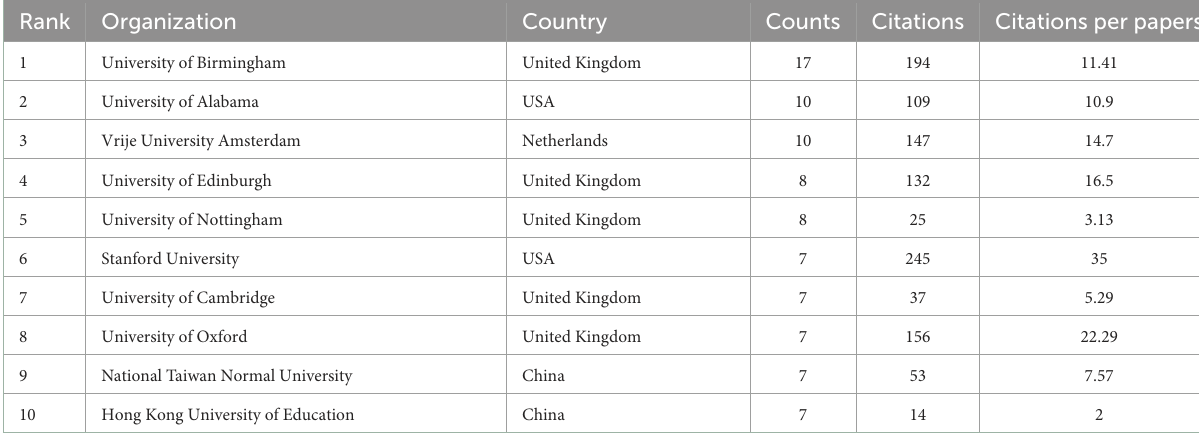
TABLE 5 Top 10 organizations in the moral education research